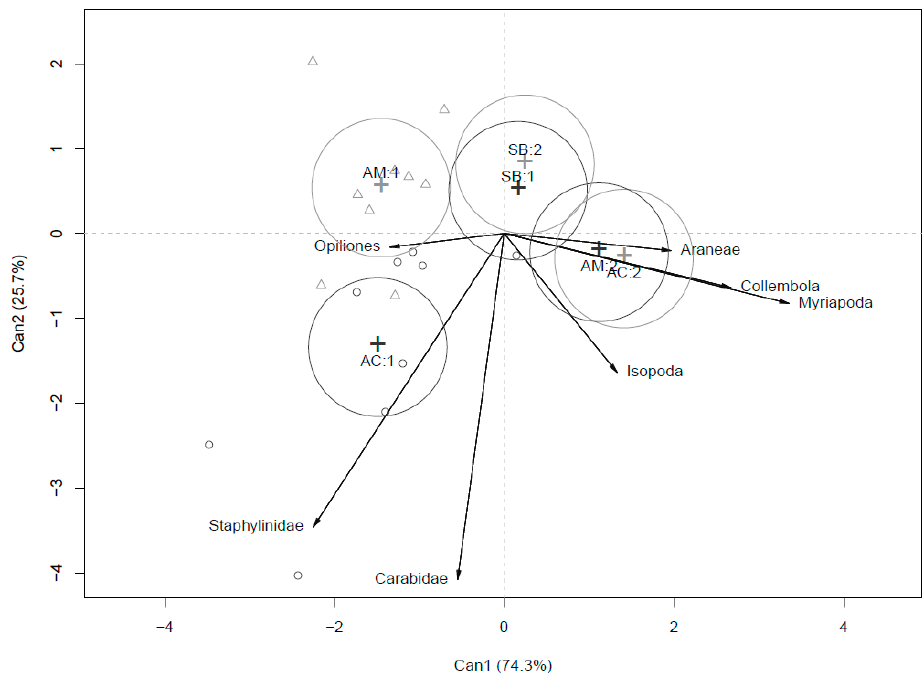
Figure 3. CDA output for arthropods abundance in the three compared systems (SB, AC and AM) pooling the two-year rotation.